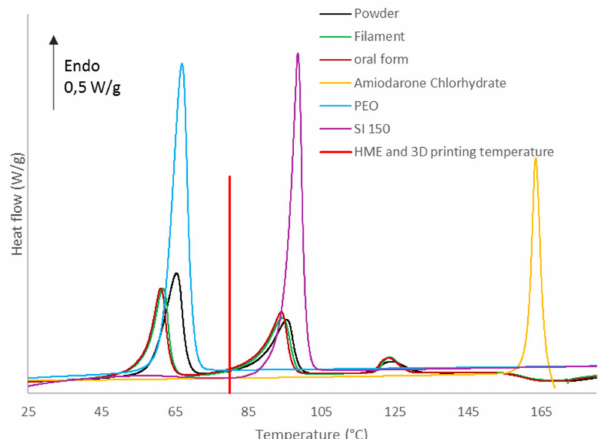
Figure 12. DSC thermoanalytical curves of formulated powder, filament and oral form (formulation B).